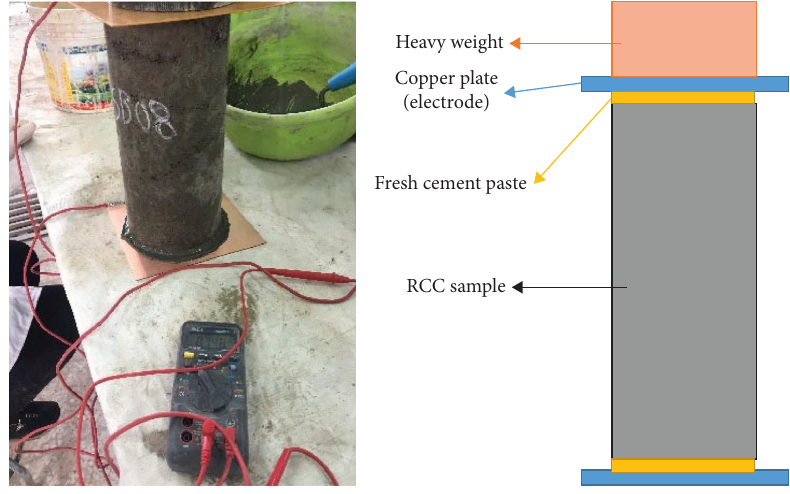
Figure 6: Electrical resistance